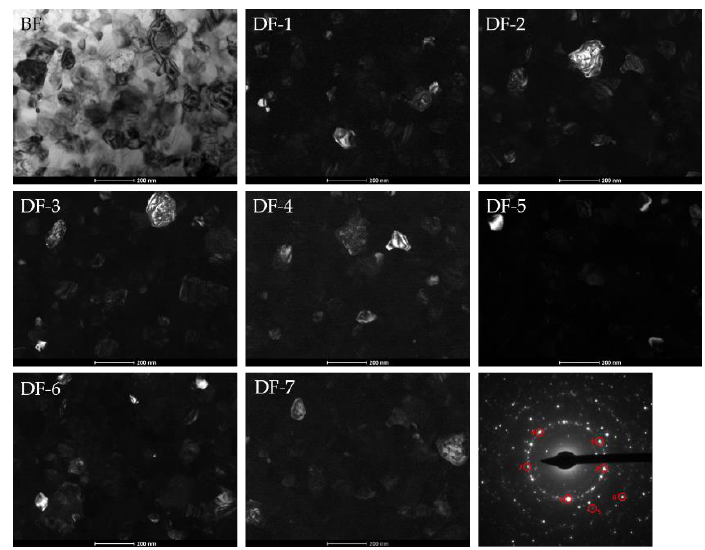
Figure 9. Bright field image, set of dark field images and selected area diffraction patterns of Fe 85.45 Cu 0.55 B 14 annealed at 370 °C.